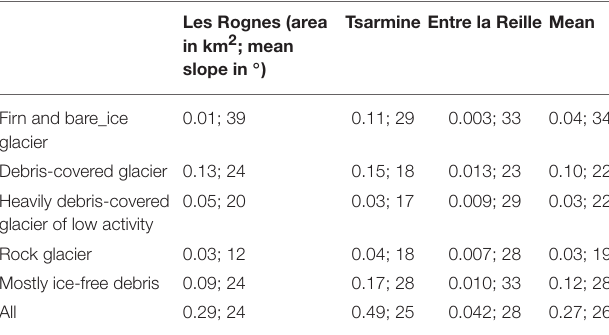
TABLE 3 | Area (in km 2 ) and mean slope angle (in degree) of the main components of these glacier systems.